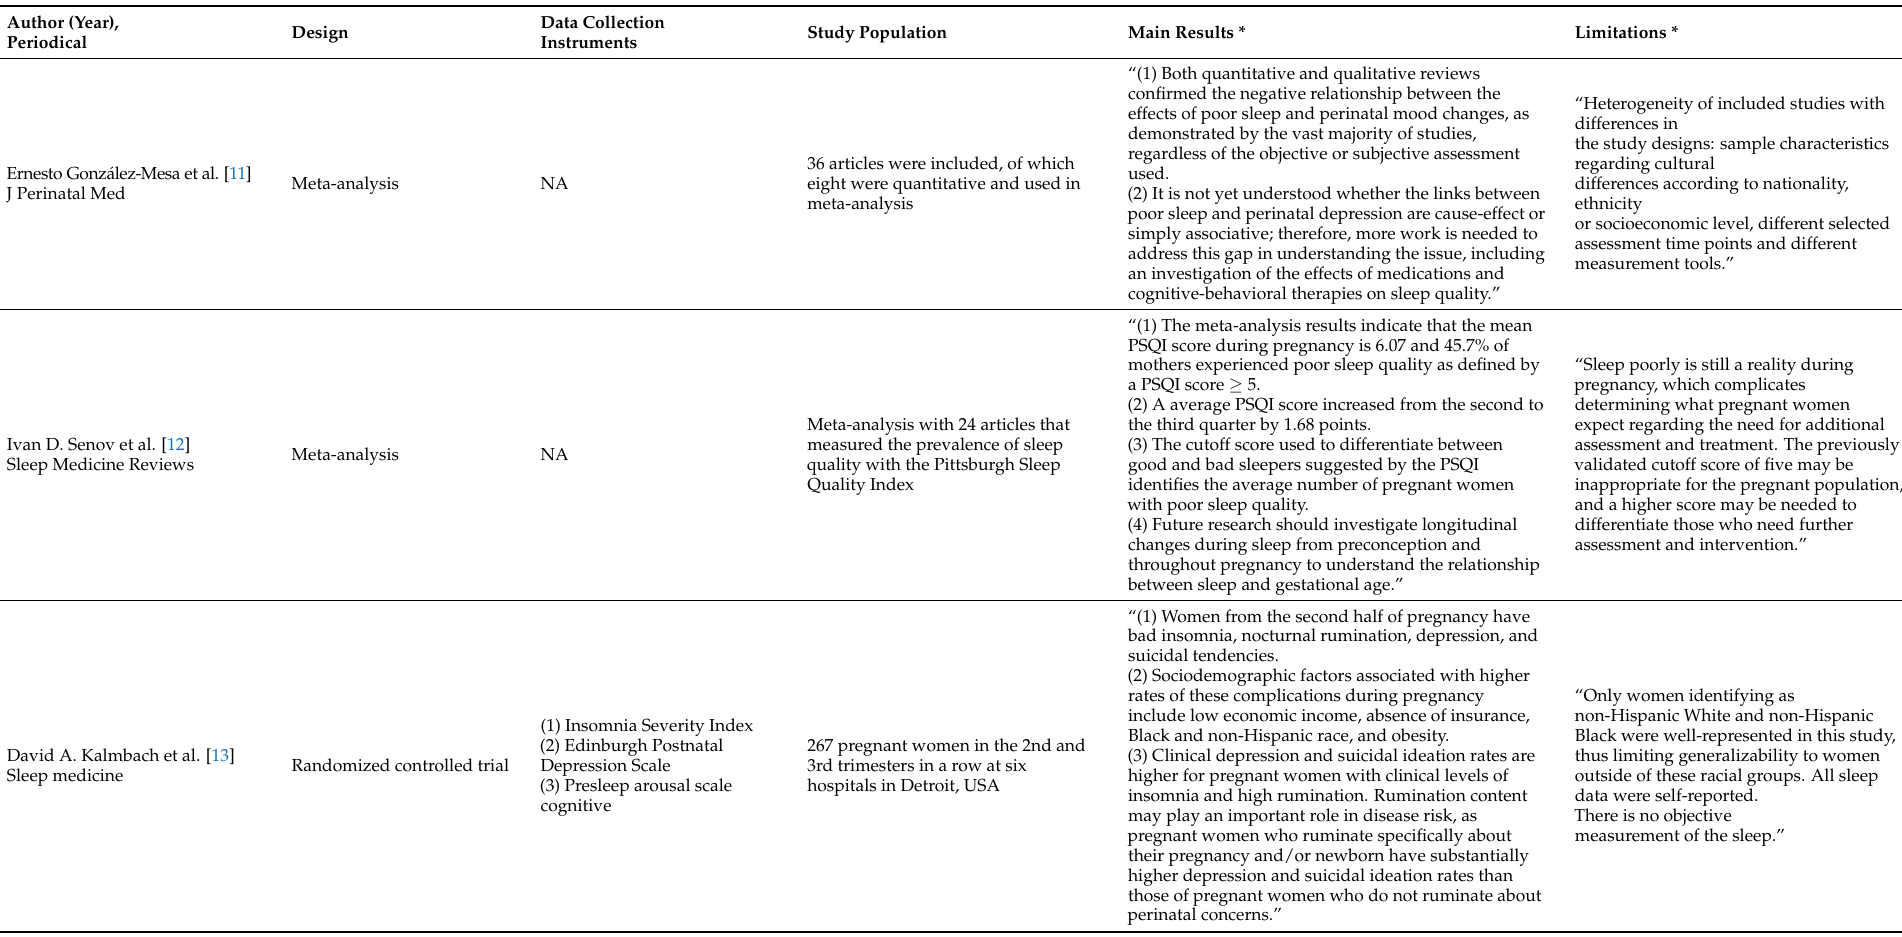
Table 2. Summary of the results of the included